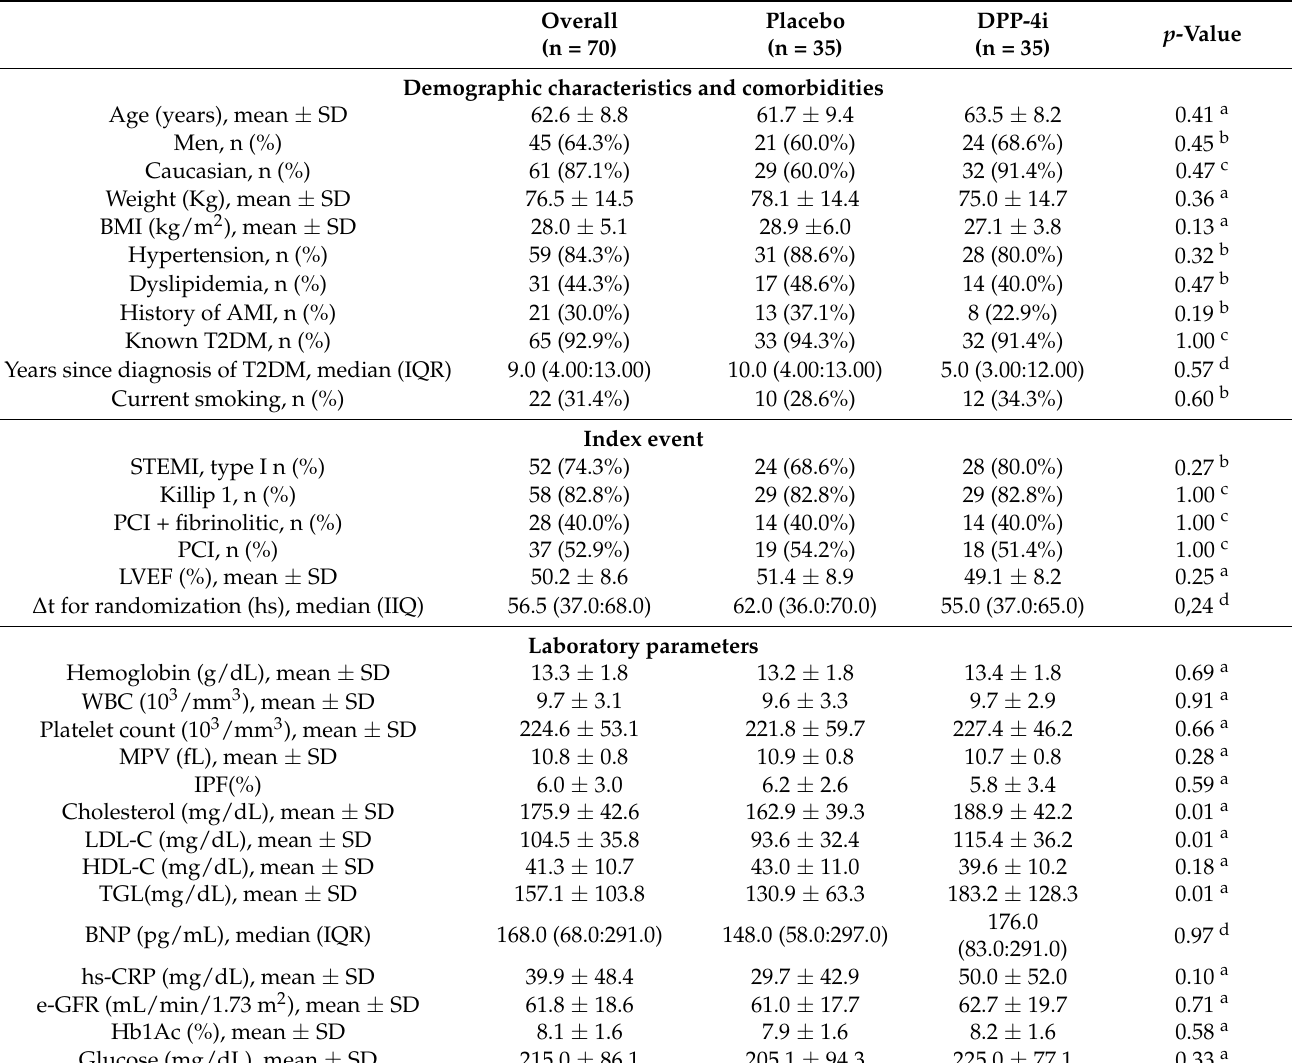
Table 1. Baseline characteristics of